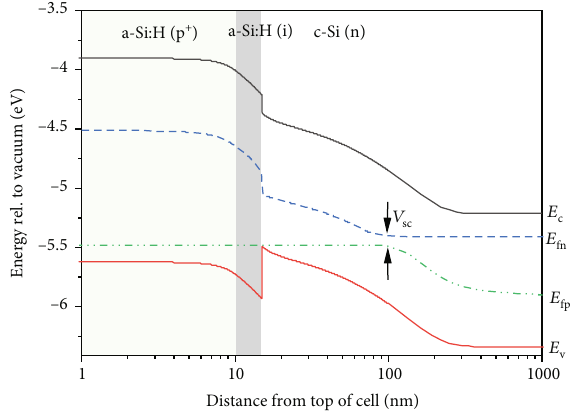
Figure 5: Energy band diagram for SHJ1 structure under illumination. Note that thermionic emission across the SHJ is ignored.